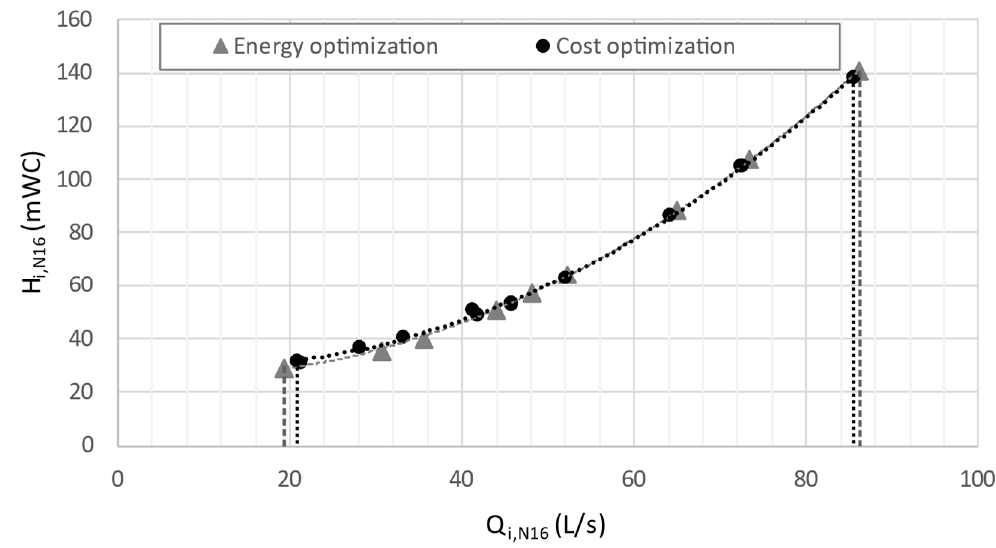
Figure 4. Setpoint curve for pumping station N16.